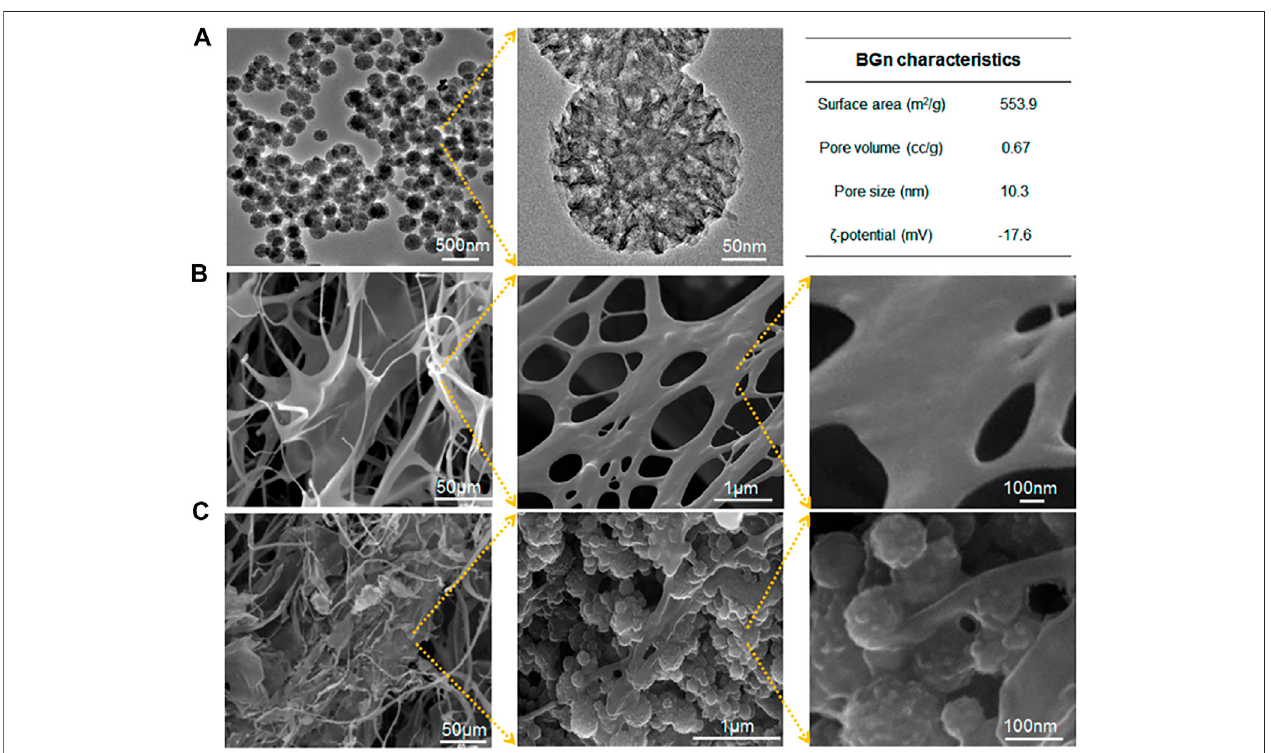
FIGURE 3 | Characteristics of BGn and BGn/Col gel. (A) TEM images of BGn at different magni fi cations with characteristics summarized. (B,C) SEM images of freeze-dried gels at different magni fi cations: (B) Col and (C) BGn/Col. Reprinted with permission from Mahapatra et al. (2016). Copyright © 2016, American Chemical